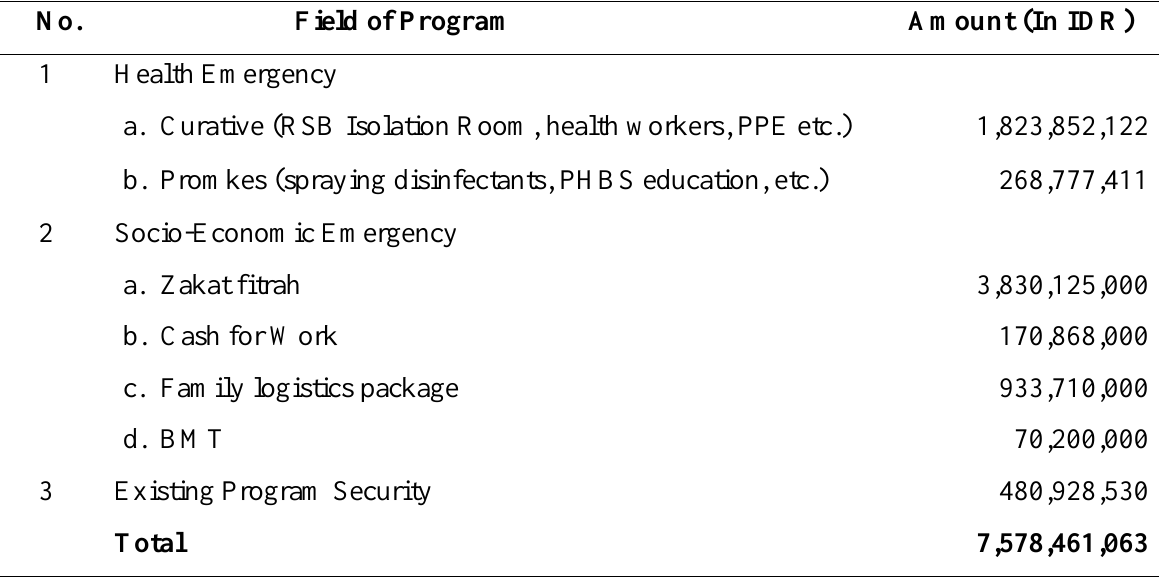
Table 1 Distribution of Baznas Zakat on Handling